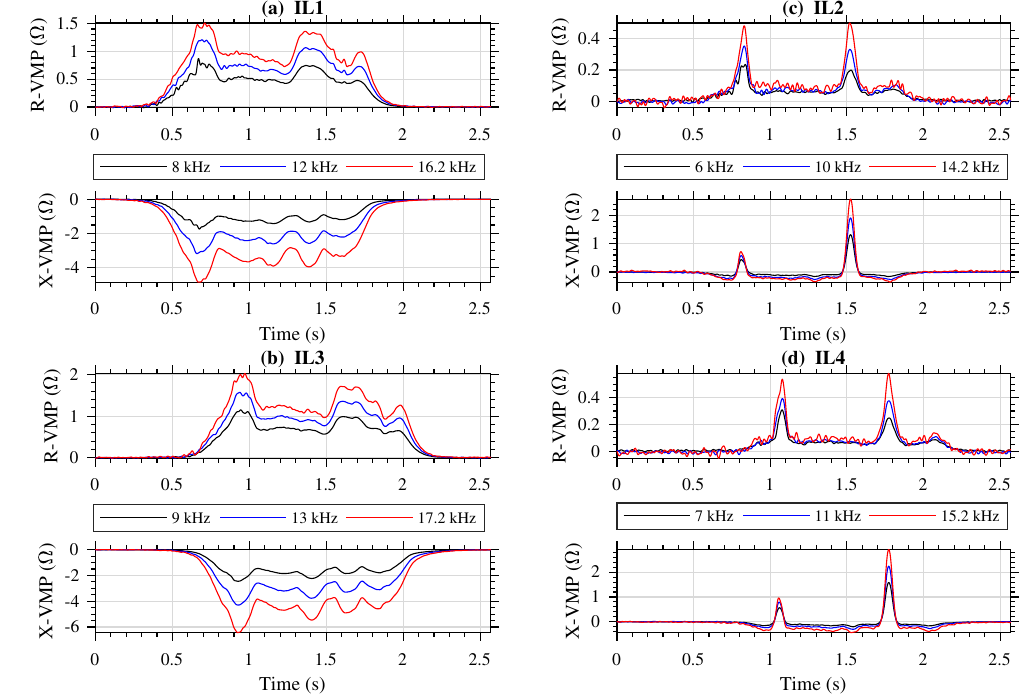
Figure 8. VMPs of a truck shown in Figure 7a; R-VMP and X-VMP denote the real and the imaginary impedance components; stimulation frequencies are listed in the legend; ( a ) the first standard IL1 sensor, ( b ) the second standard IL3 sensor ( c ) the first slim IL2 sensor, and ( d ) the second slim IL4